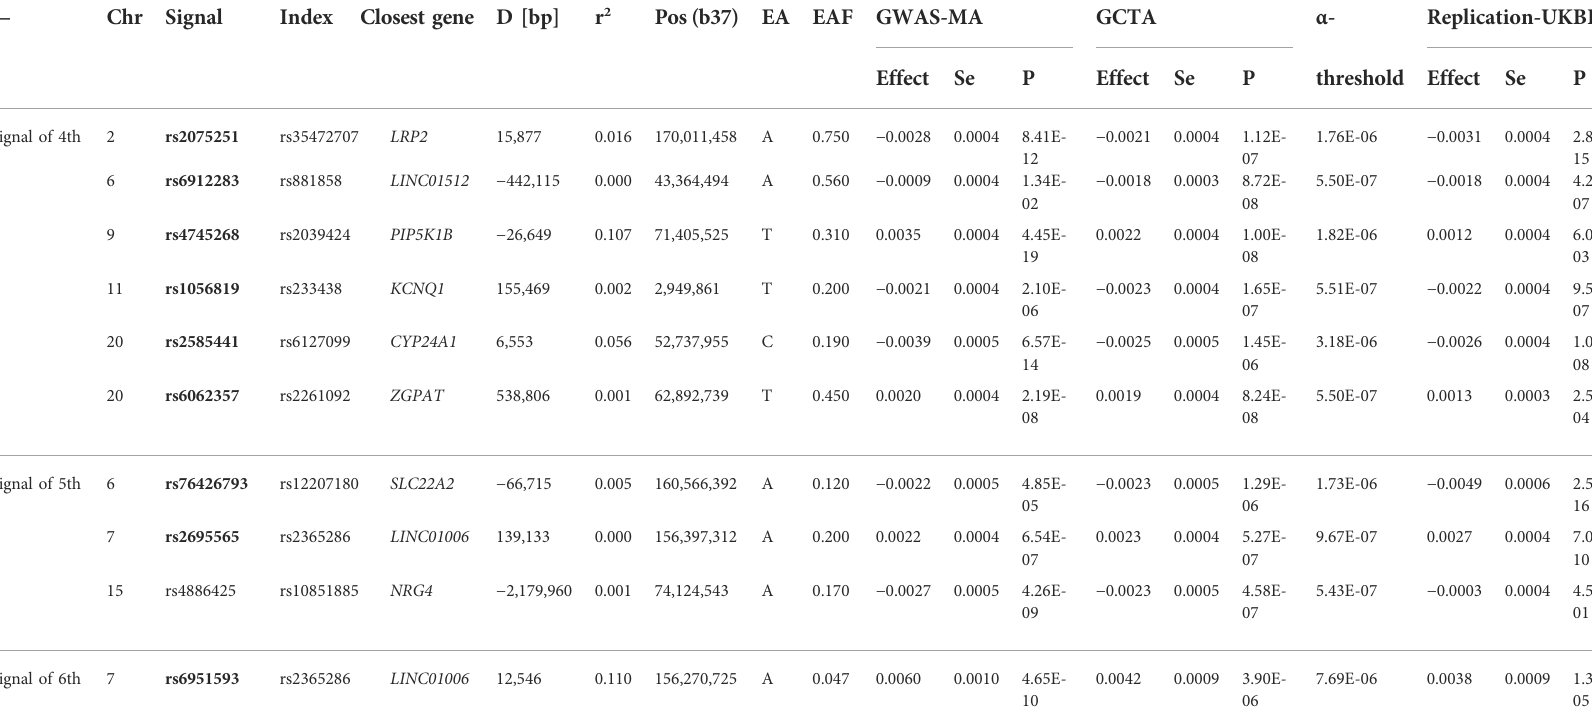
TABLE 1 ( Continued ) Summary of novel independent eGFR-associated signals identi fi ed by quasi-adaptive method and replication